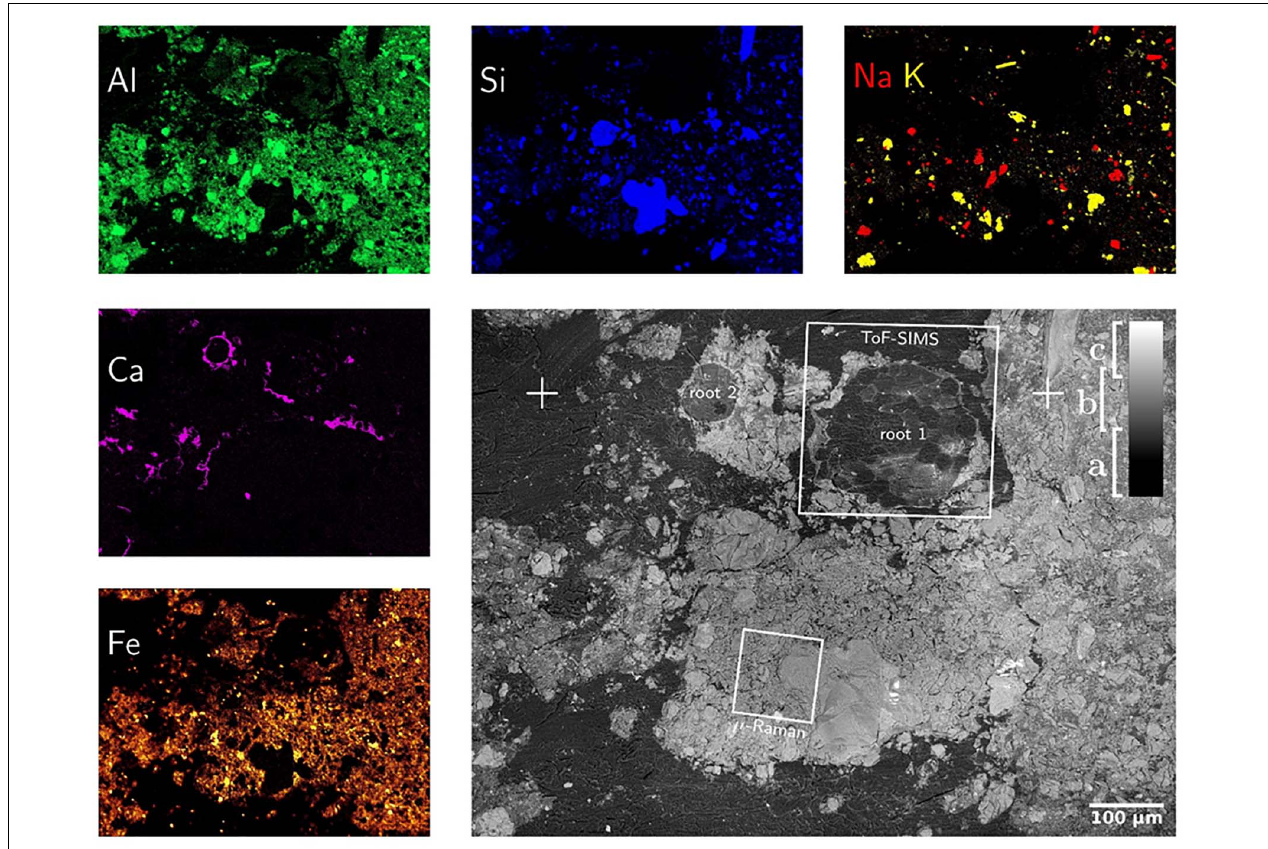
FIGURE 5 | SEM-BSE (gray figure) and SEM-EDX maps of mineral-forming elements. SEM-BSE contrast allows for separation of resin (a), light (b) and heavy (c) minerals as well as the identification of root-cells. The positions marked as “ + ” are identical with those in Figure 3 . The SEM-EDX false-color maps show exactly the same field-of-view such that SEM-BSE contrast can be linked to elemental composition. Please note that the Calcium distribution is almost identical to that of phosphorous which hints to calcium phosphates precipitated around the root